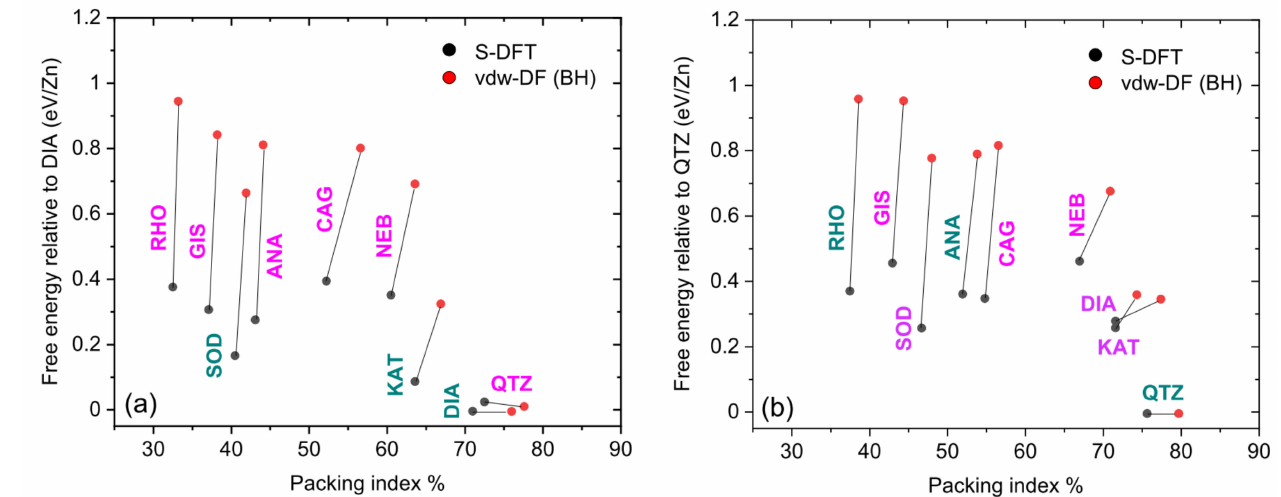
Figure 2. Relative energies for S-DFT (black dots) and vdW-DF (red dots) at 0 K, calculated using the BH functional [20]. ( a ) ZIFs with the HMeIm ligand. ( b ) ZIFs with the HEtIm ligand. The line segments connect the results of S-DFT and vdW-DF calculations for the same ZIF structure. The green labels denote the structures synthesized experimentally while the magenta labels denote hypothetical